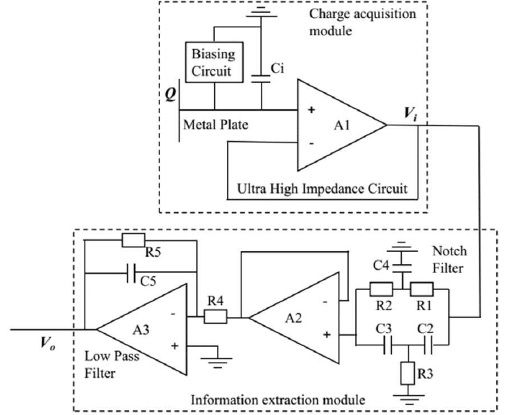
Figure 7. Circuit diagram of detection frontend.